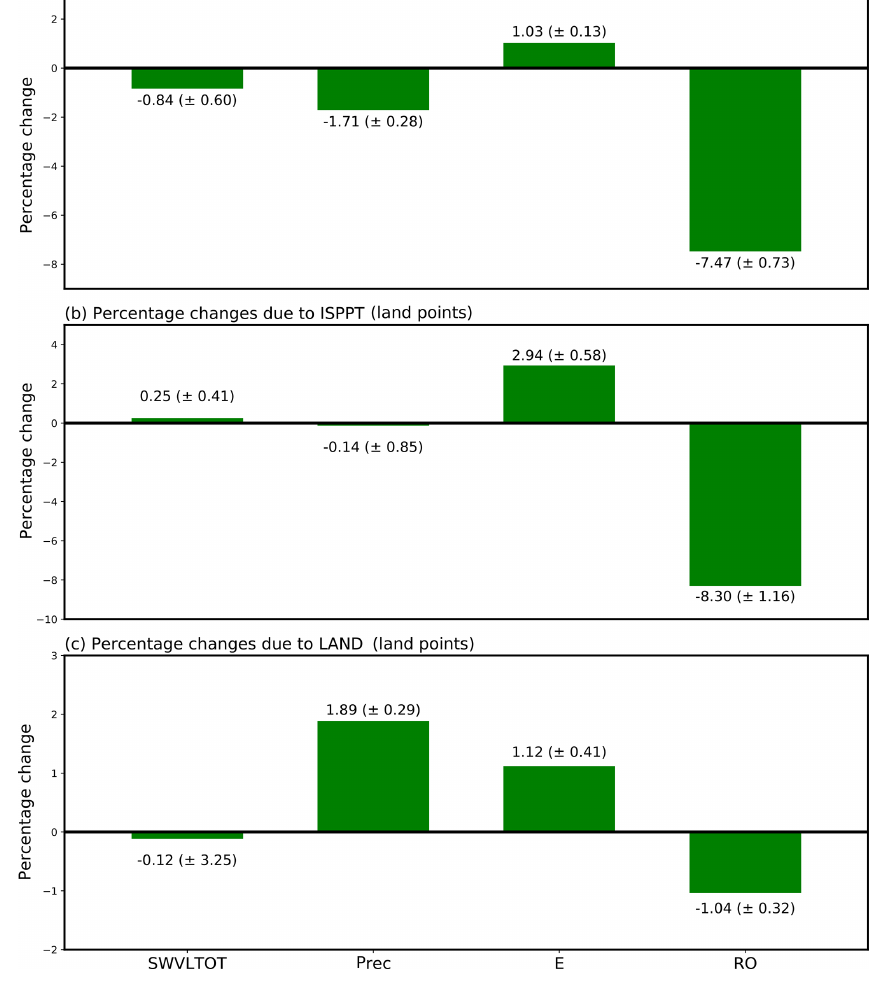
Figure 7. Average percentage change, relative to CTRL, in the global mean of (a) SPPT simulations, (b) ISPPT, and (c) LAND. All data were restricted to land-points only. For LAND, Antarctica was also excluded. Variables shown are total soil water content (SWVLTOT), pre- cipitation (Prec), evaporation ( E ), and runoff (RO). Uncertainty estimates are twice the standard deviation of the five individual